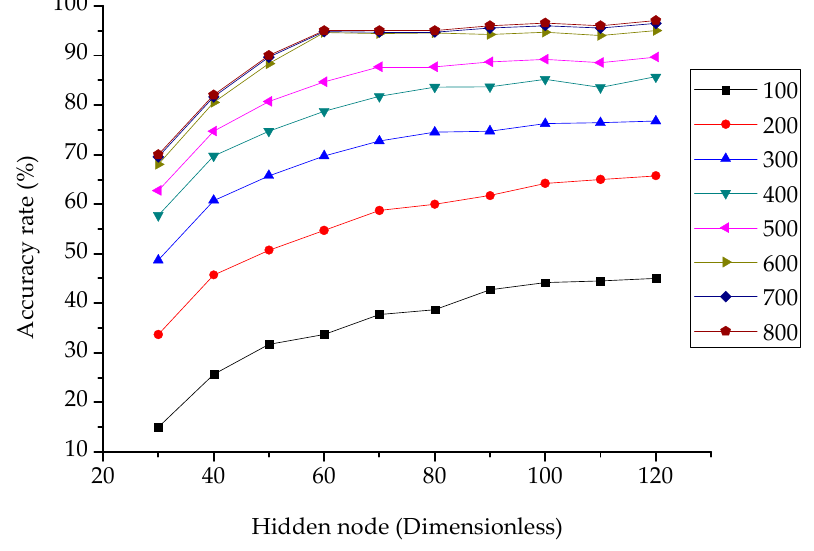
Figure 8. The results of ELM with different sample sizes and hidden nodes.